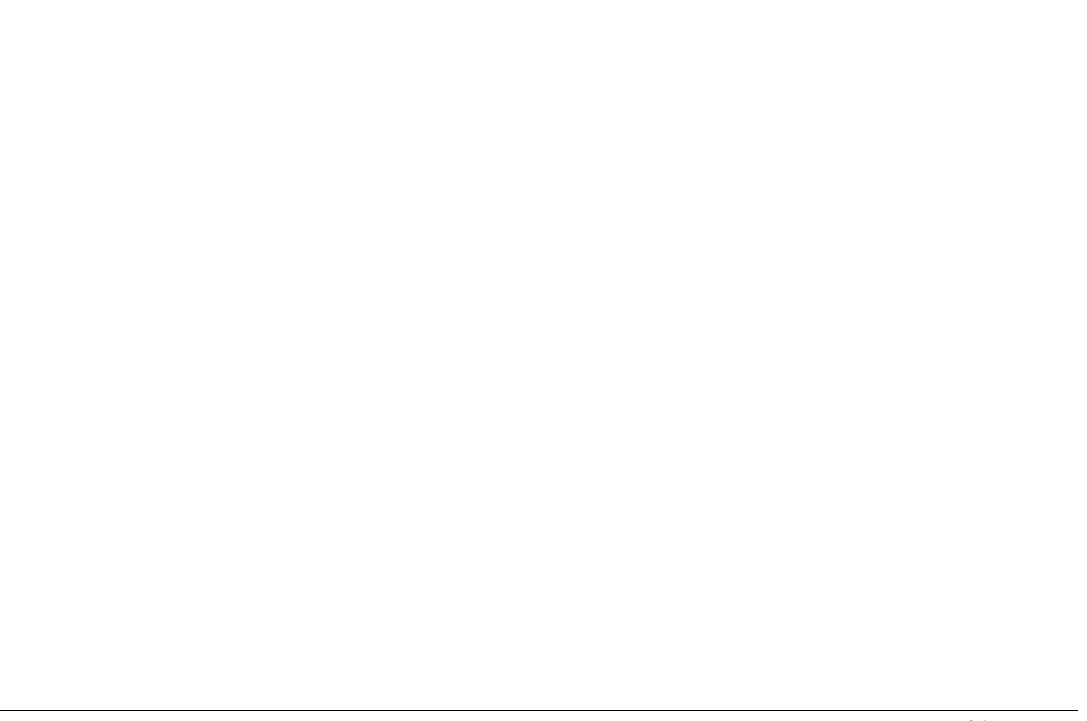
Figure 10. Distribution of the Nusselt number along ( a ) simple, ( b ) sinusoidal, ( c ) triangular, ( d ) square tube in presence of different inlet